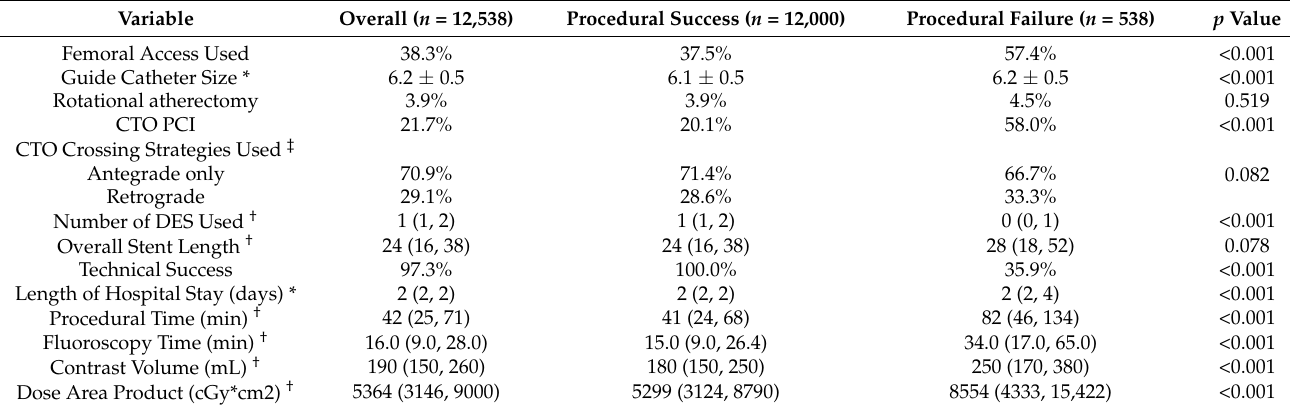
Table 3. Technical and procedural characteristics of patients undergoing percutaneous coronary intervention (PCI) for stable coronary artery disease (CAD) categorized according to procedural